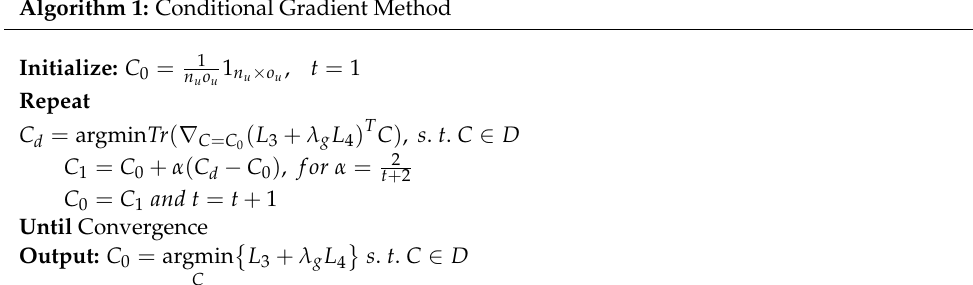
Algorithm 1: Conditional Gradient